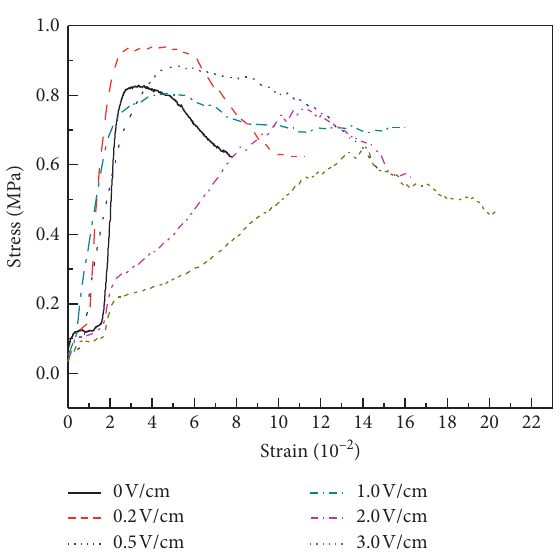
Figure 6: The change in the stress-strain curve of the samples after electrochemical modification with different potential